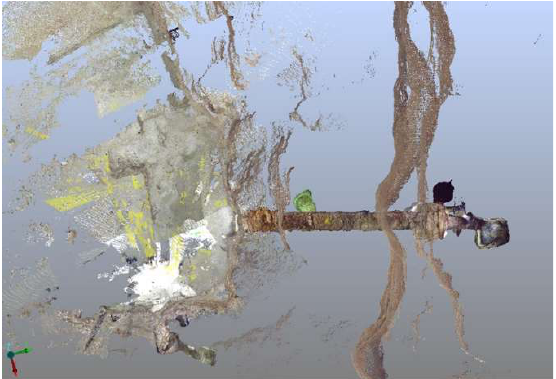
Table 1. Laser scan parameter